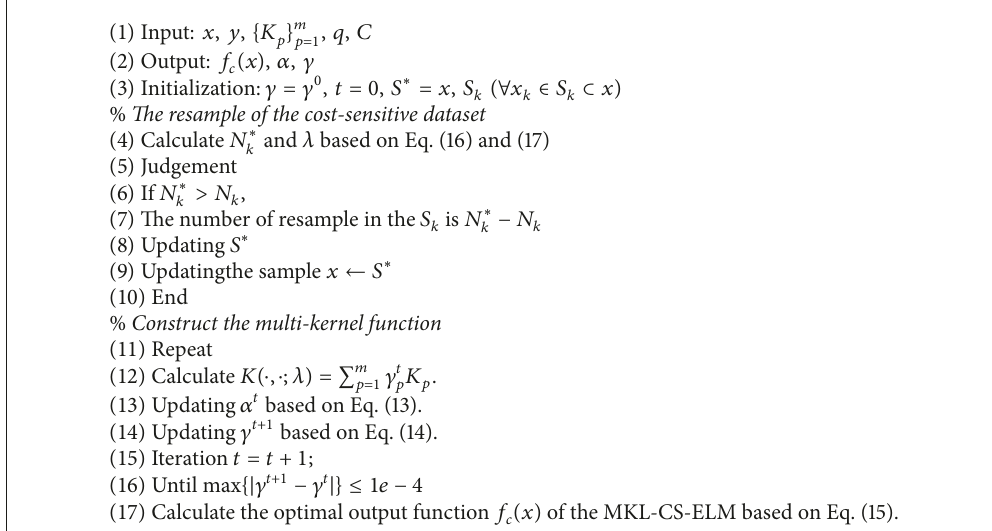
Algorithm 1: Oversampling